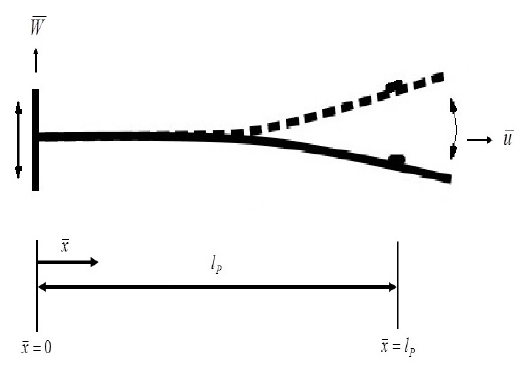
Figure 10. Schematic diagram of SESS system.